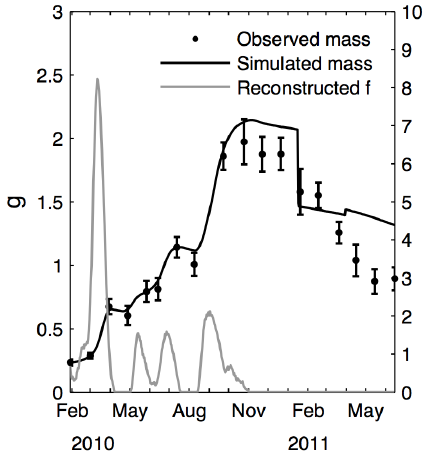
Figure 6. Comparisons of observed and modeled DFM with the reconstructed functional response. Functional response without standardization (grey) was obtained with DFM observations. Simulated DFM is shown by solid lines, observations are shown by dots.